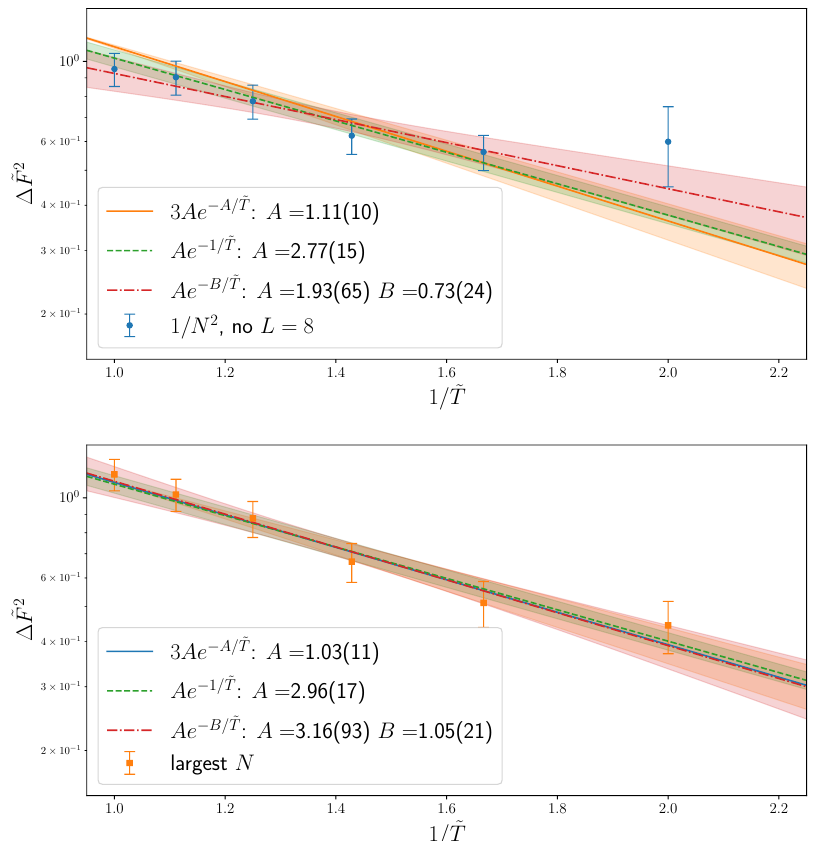
[Upper] Di(cid:11)erent exponential (cid:12)ts are shown together with the lattice data obtained from a simultaneous continuum and large- N extrapolation (reported in table 2). [Lower] The same exponential (cid:12)ts are shown using a di(cid:11)erent dataset where the largest- N results are used at each temperature (reported in table 3). In both cases, only (cid:12)ve rightmost data points are included in the (cid:12)ts, corresponding to ~ T 0 : 9. The (cid:12)ts are all compatible with the data and among each other, (cid:20) with the two-parameter (cid:12)t having the largest uncertainties. Although we don’t (cid:12)nd any theoretical reason that the overall coe(cid:14)cient is integer, numerically it appears to be rather close to